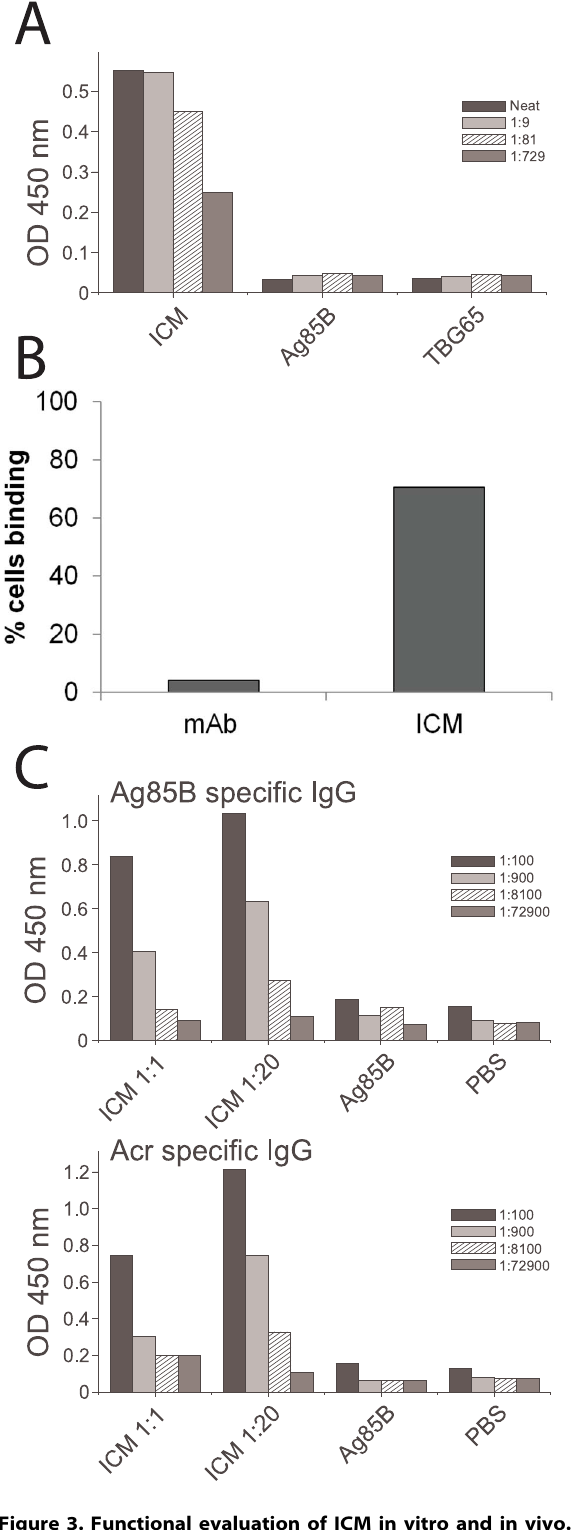
Figure 3. Functional evaluation of ICM in vitro and in vivo. A) Complement C1q binding ELISA; ICM were used at the 1:20 antibody- antigen ratio and the neat sample contained 5 m g/m total protein (ICM) or the equivalent amount for individual components; each bar represents mean value from triplicate assays and the patterns indicate serial dilutions. B) Analysis of binding of ICM to spleen-derived APCs by flow cytometry; shown are the proportions of cells (out of